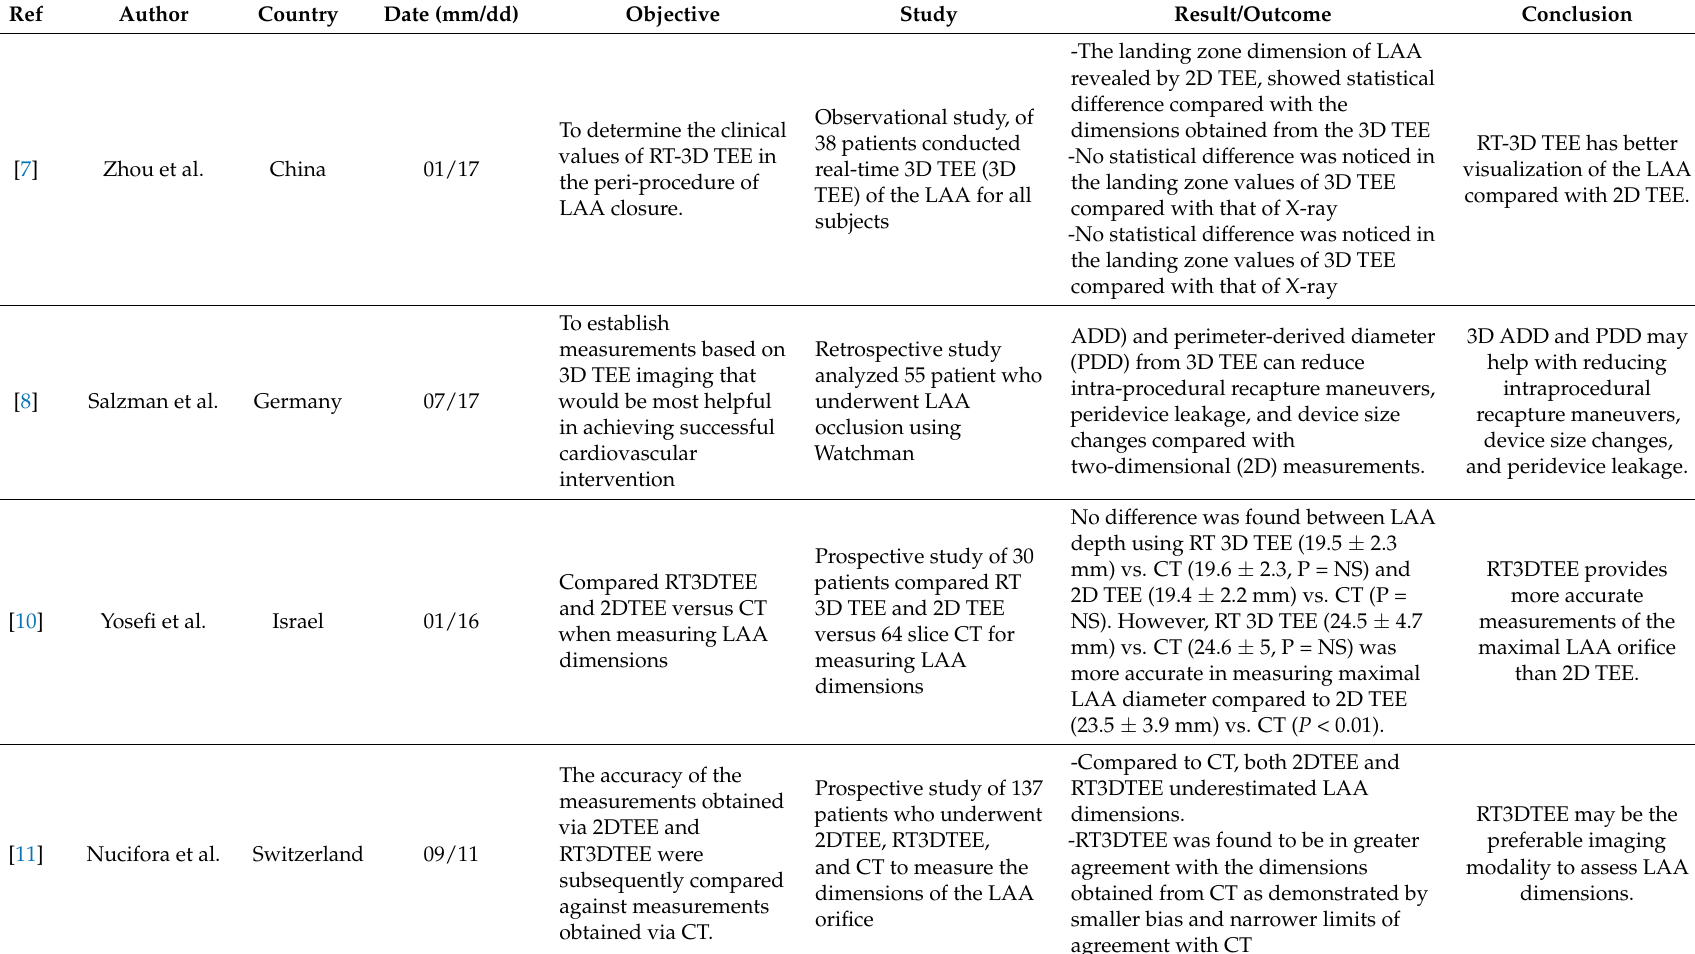
Table 2. Literature review summary table for 3D TEE vs. 2D TEE in the preprocedural assessment of the left atrial